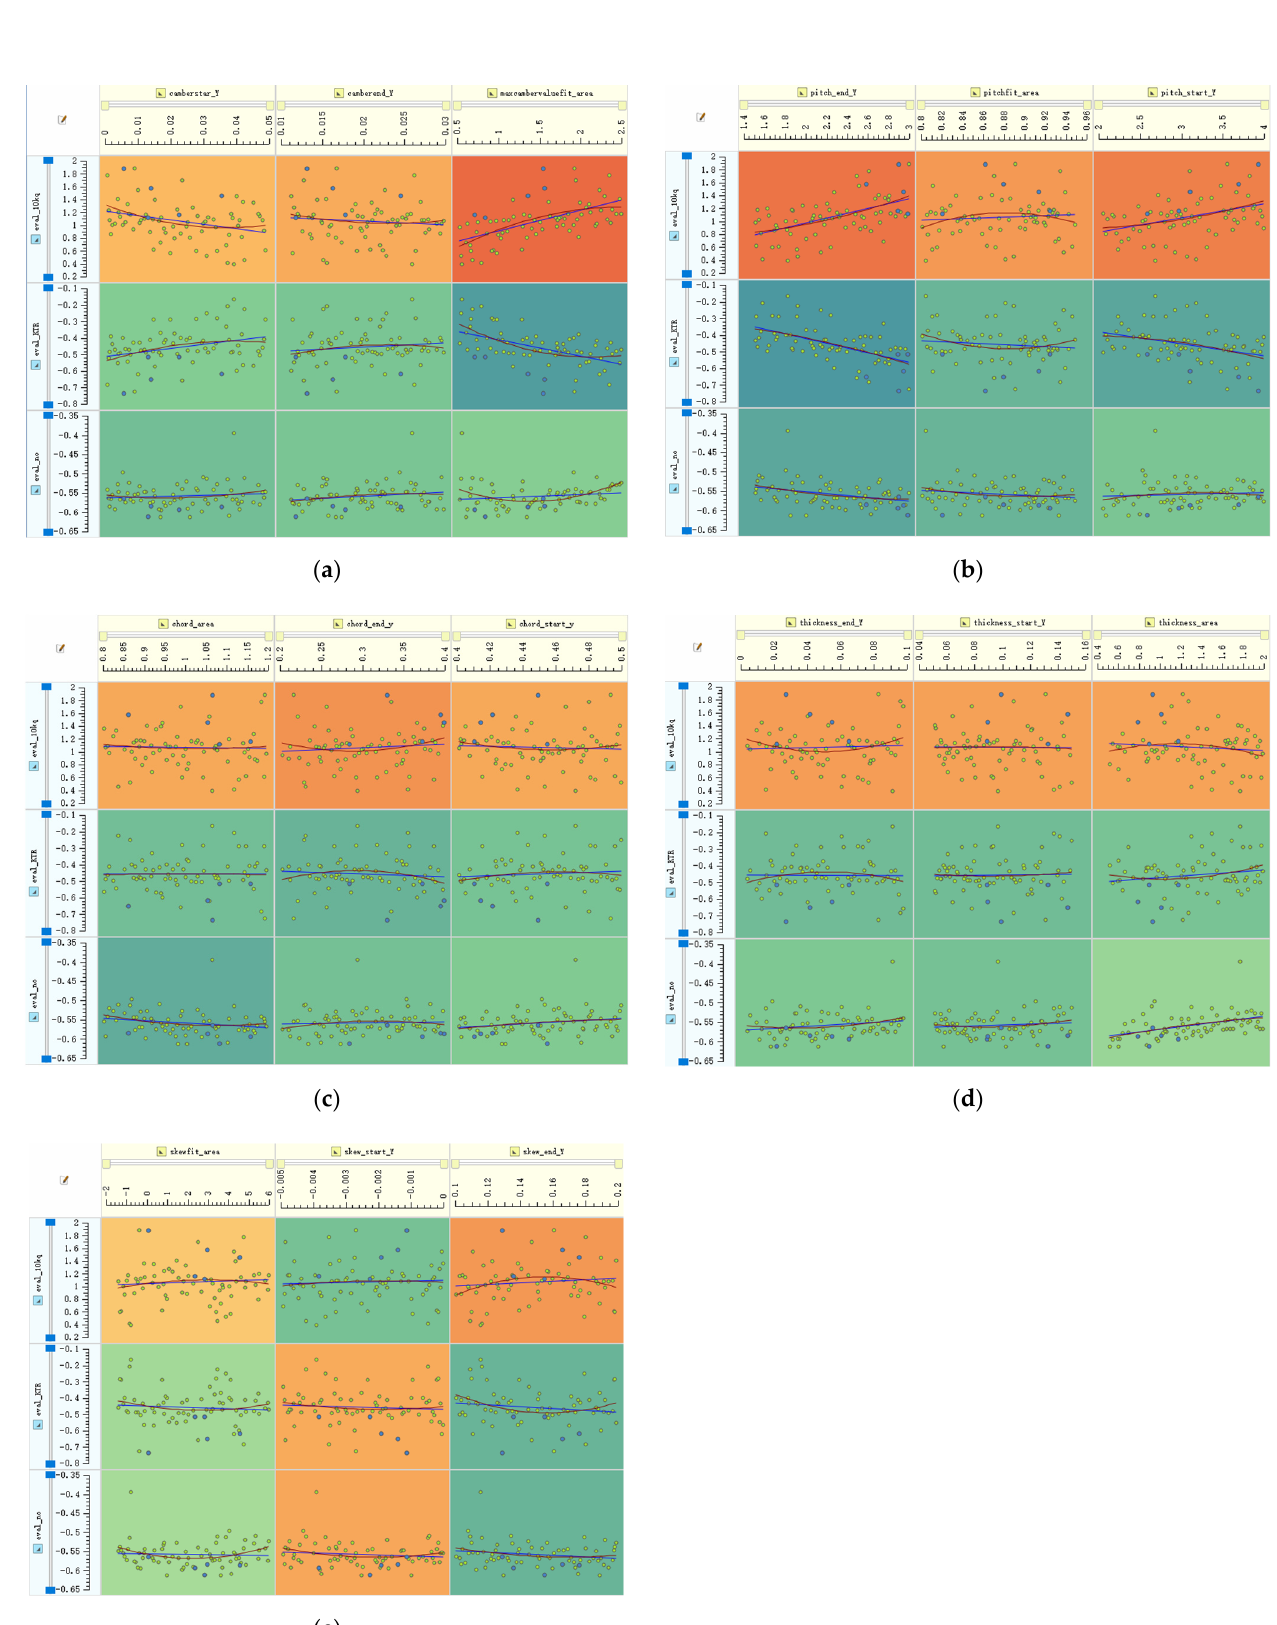
Figure 15. Optimization Design Variable Sensitivity Analysis: ( a ) Sensitivity of camber to optimiza- tion objective; ( b ) Sensitivity of pitch to optimization objective; ( c ) Sensitivity of chord to optimization objective; ( d ) Sensitivity of thickness to optimization objective; ( e ) Sensitivity of skew to optimiza- tion